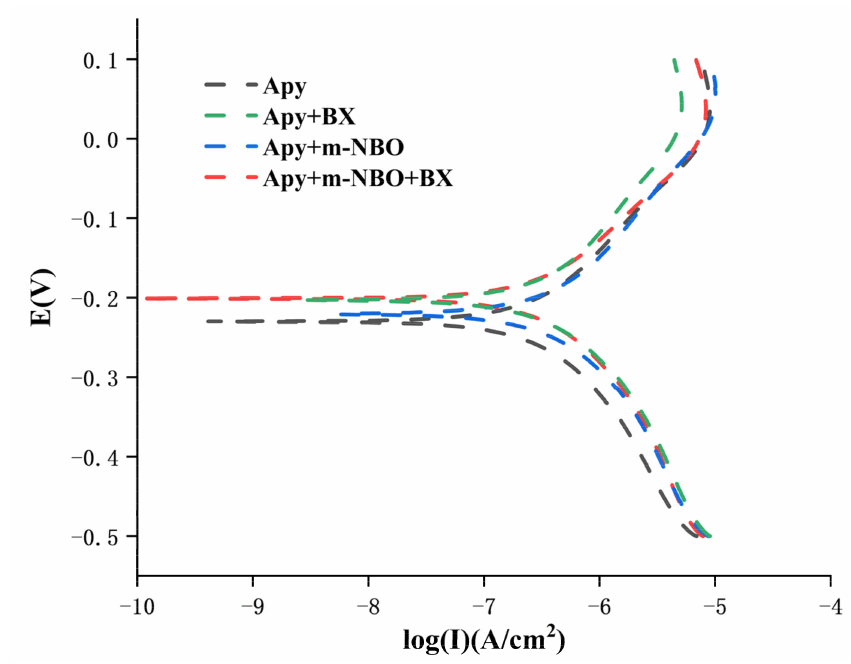
Figure 11. Tafel curves of the arsenopyrite electrode in the presence of m-NBO and NaBX at pH = 11.5; scanning rate: 10 mV/s, C (m-NBO) = 0.3 mol · L − 1 , C (NaBX) = 1.6 × 10 − 3 mol · L − 1